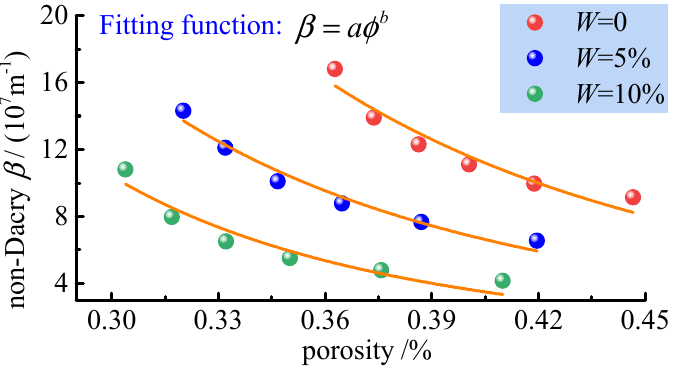
Figure 17. Effect of porosity on the non − Darcian flow factor of the percolation system of fractured coal media.